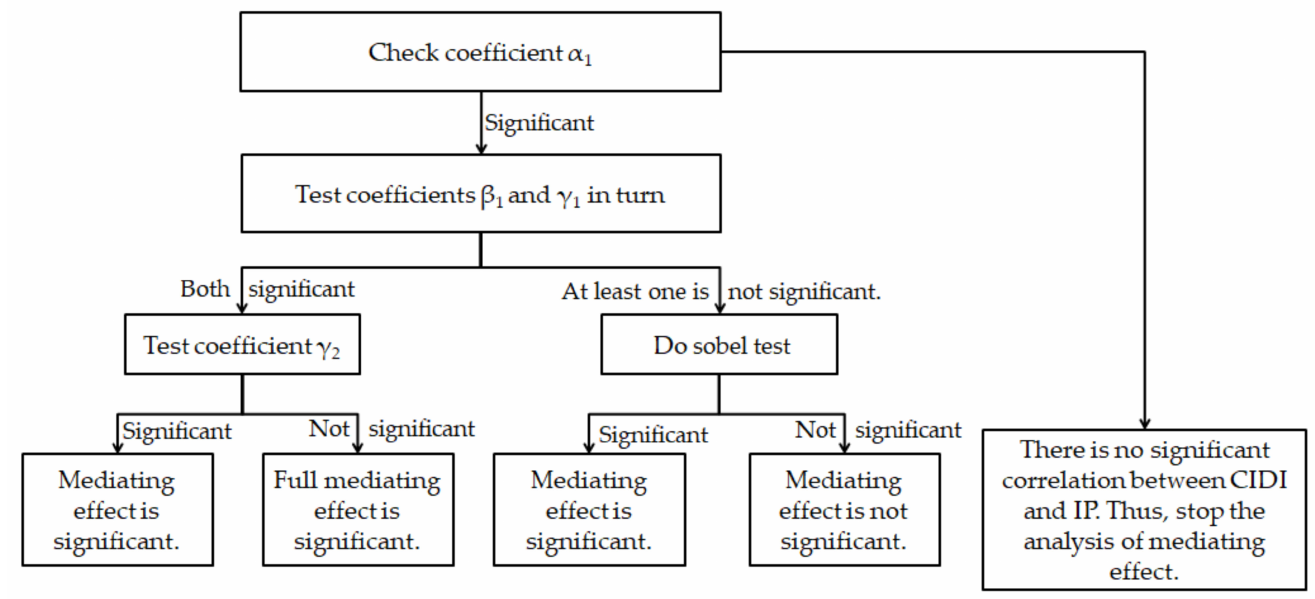
Figure 2. Test procedure of mediating effect. Note: α 1 represents the regression coefficient corre- sponding to the institutional pressure in model 1 of institutional pressure and corporate carbon information disclosure; β 1 refers to the regression coefficient corresponding to institutional pressure in model 2 of institutional pressure and enterprise peer influence; γ 1 refers to the regression coeffi- cient of the mediating variable enterprise peer influence in of the mediating effect test of enterprise peer influence on institutional pressure and corporate carbon information disclosure (model 3); γ 2 refers to the regression coefficient of explanatory variable institutional pressure in the mediating effect test of enterprise peer influence on institutional pressure and corporate carbon information disclosure (model